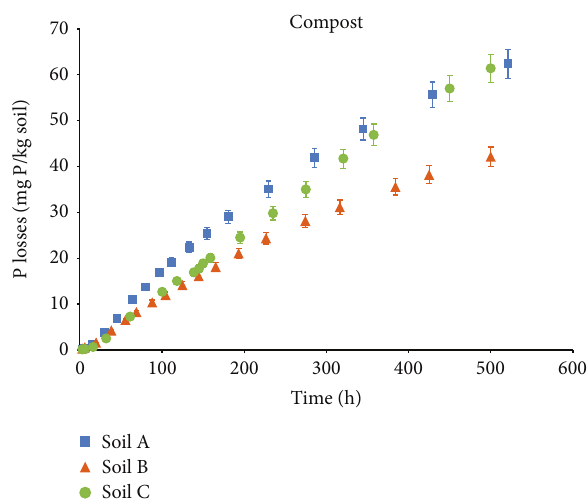
Figure 3: DRP losses by leaching in soil-compost mixtures. Error bars indicate the standard error of the mean ( 𝑛 = 3 ).